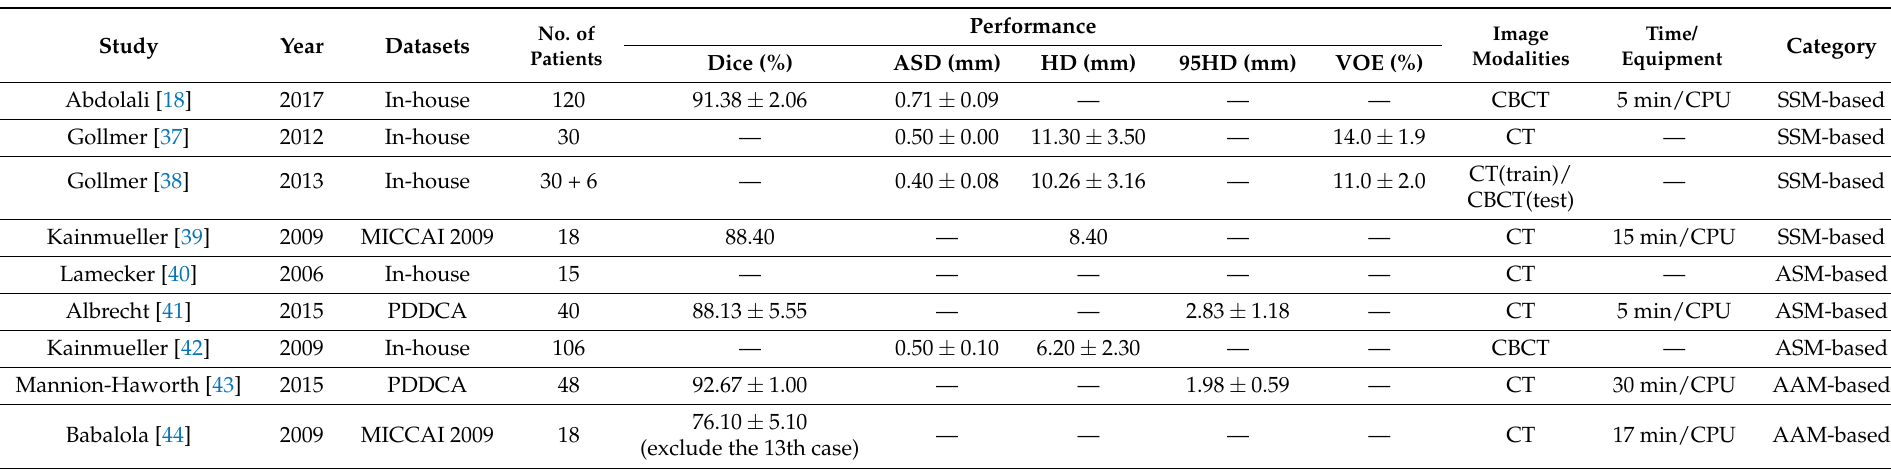
Table 3. Summary of SSM-based, ASM-based and AAM-based